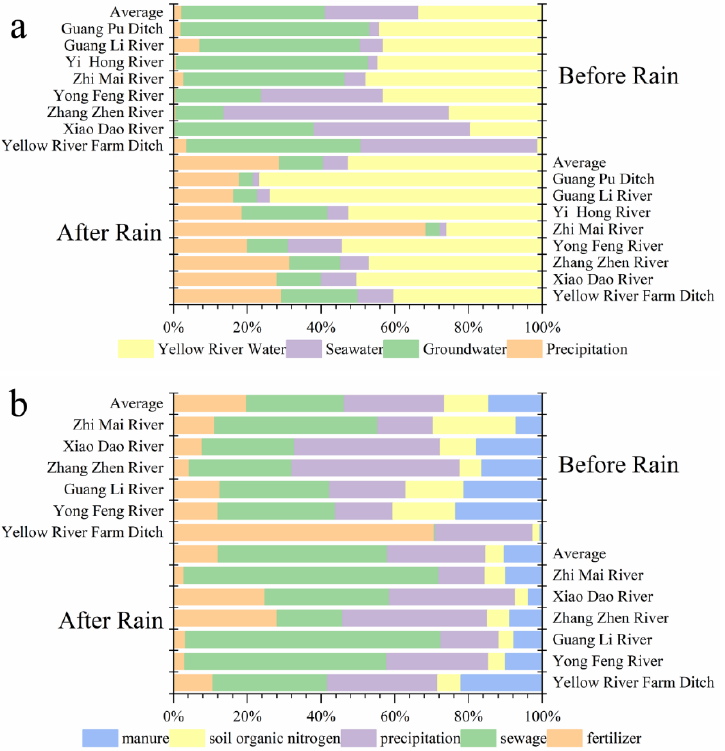
Figure 4. The average recharge ratios of river water ( a ) and nitrate sources ( b ) in the study area.